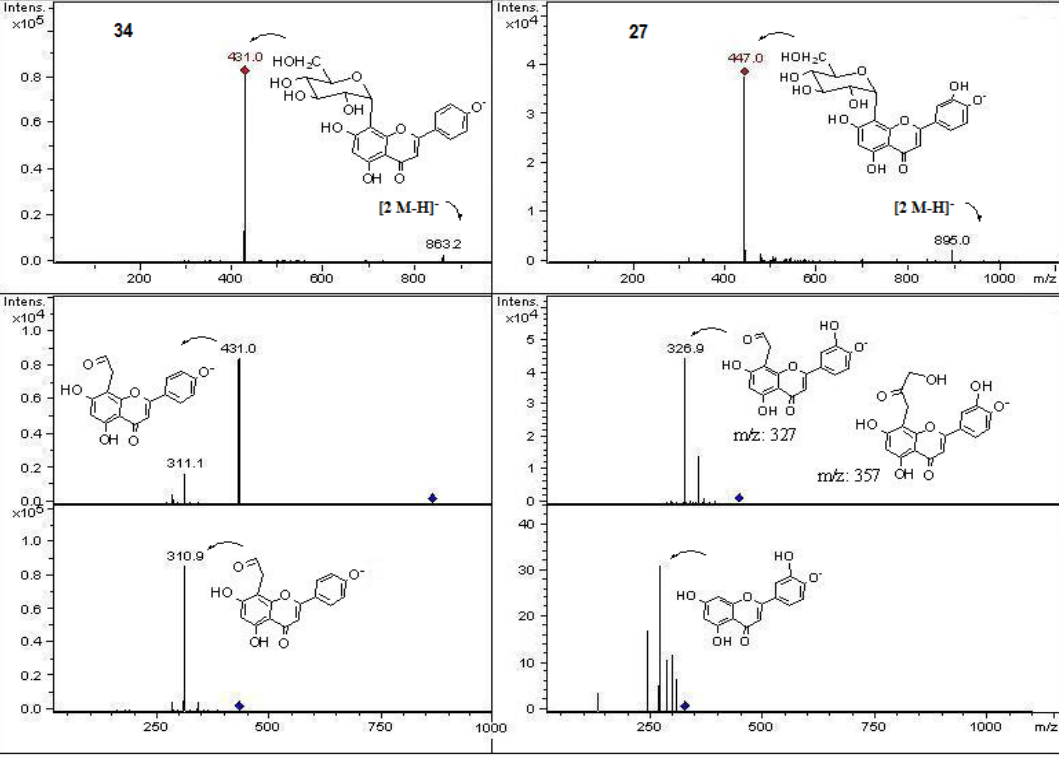
Figure 11. Structures, fragmentation, full ESI-MS and MS-MS spectra of peaks 29 , 30 and 35